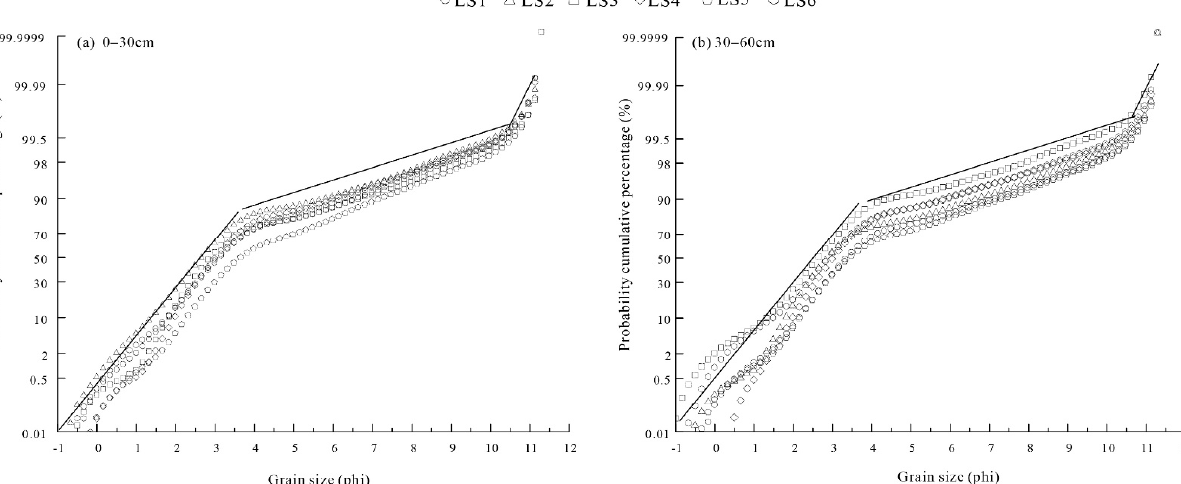
Figure 3. Log-probability cumulative curve of grain size composition of sediments collected from different landscapes.